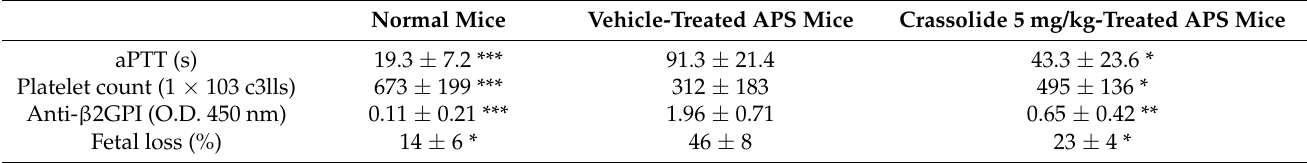
Table 1. Clinical manifestations in mice.